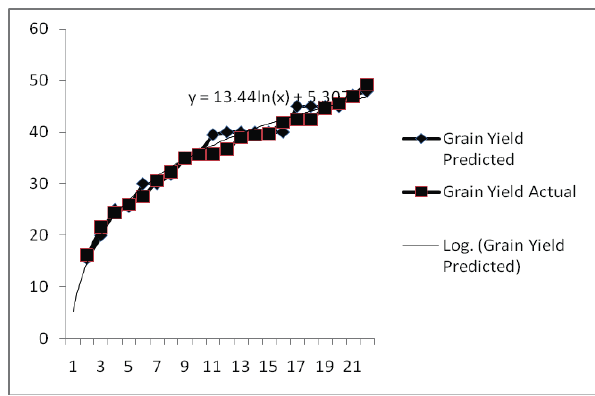
Figure 5. Predicted yield vs. actual yield with panicle length and panicle weight as